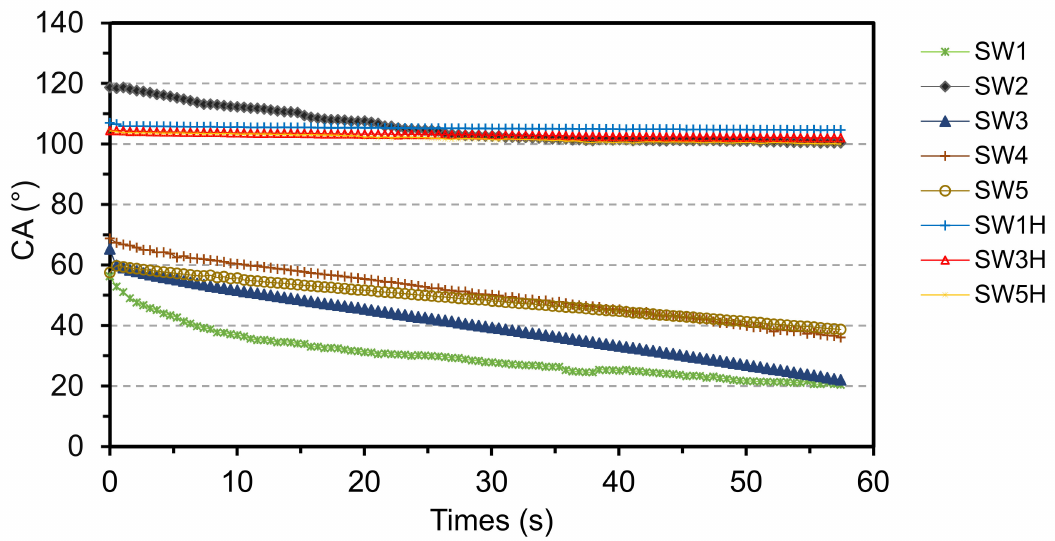
Figure 8. Dynamic wettability of the silicate coatings at the surface of wood. SW1H, SW2H, and SW5H are SW1, SW2, and SW3 post-treated the hydrophobizing dispersion (HDTMS/DTSACl).